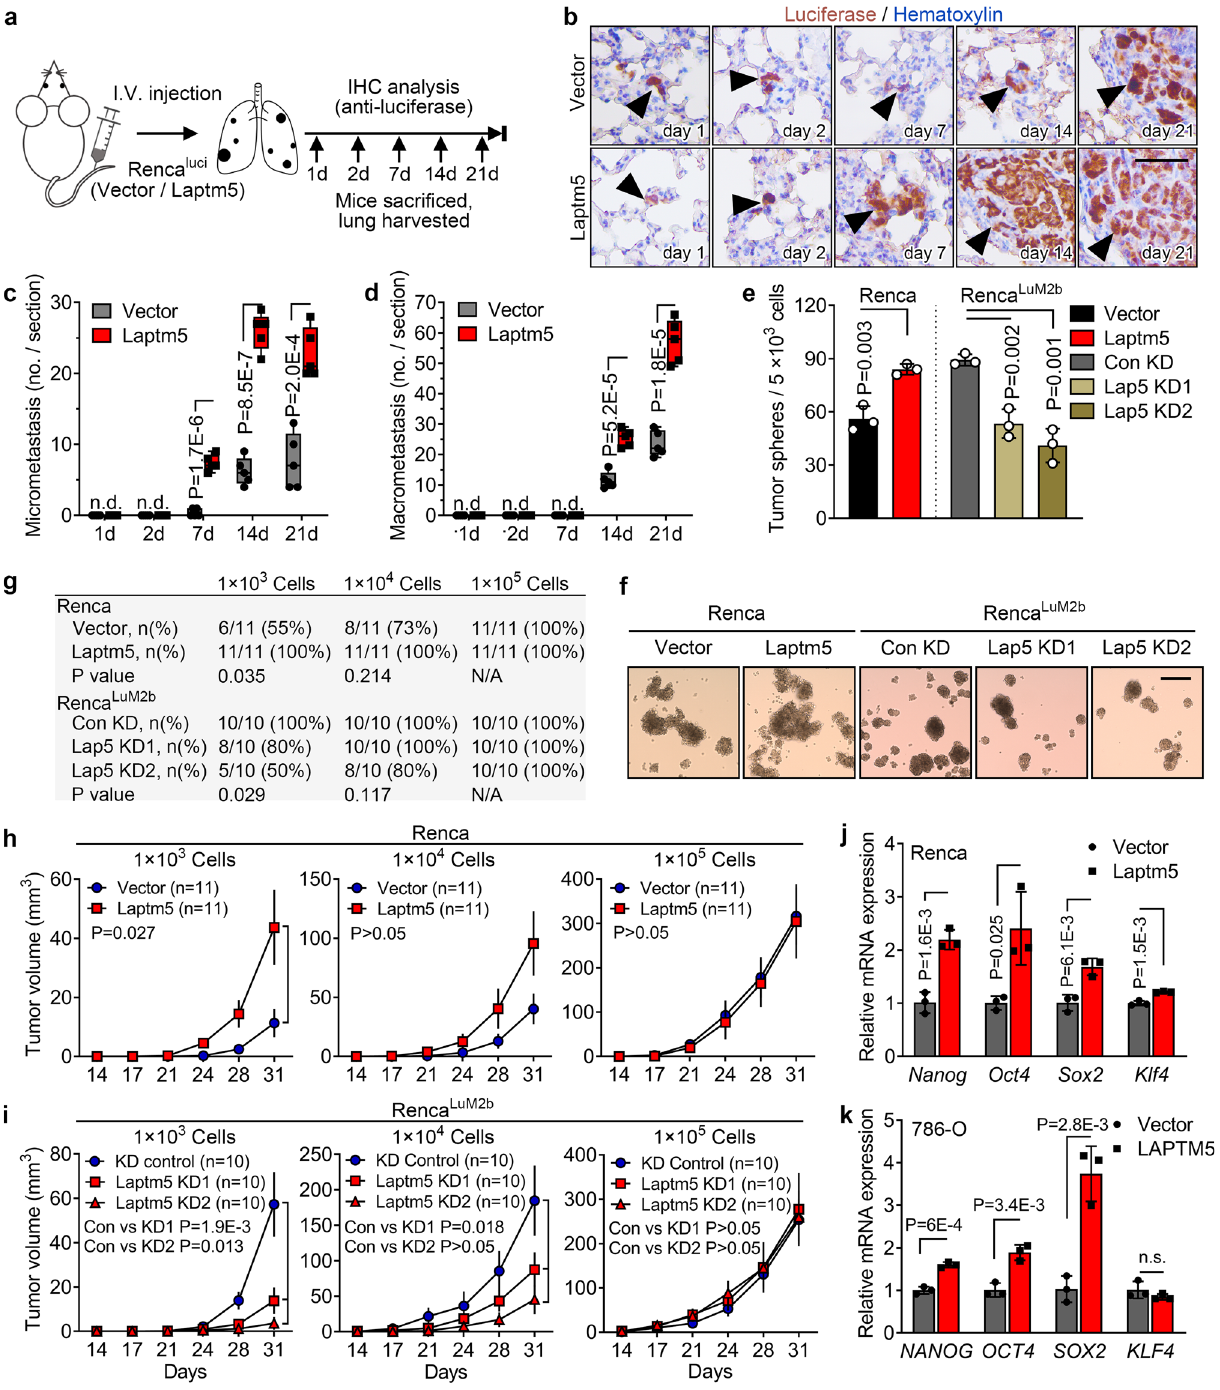
Fig. 3 LAPTM5 promotes self-renewal and cancer stem cell traits of RCC cells. a Schematic illustration for the steps of cell inoculation and lung metastases detection. I.V., intravenous. b Representative IHC images of luciferase staining in lung sections harvested from mice treated as in ( a ). Scale bar, 50 μ m. Quanti fi cation of micrometastasis (diameter < 100 μ m, c ) and macrometastasis (diameter ≥ 100 μ m, d ) per lung section in ( b ) ( n = 5 mice per group). Tumor sphere assay ( e ) and quanti fi cation of tumor sphere formation of indicated cells ( f , n = 3 per group). Scale bar, 200 μ m. g Frequencies of tumors formation in indicated groups. Tumor volumes of control and Laptm5-overexpressing Renca cells ( h , n = 11 mice per group) or control and Laptm5- silenced Renca LuM2b cells ( i , n = 10 mice per group) inoculated subcutaneously with indicated cell number. j , k qRT-PCR analysis of stemness markers in control and LAPTM5-overexpressing Renca ( j ) and 786-O cells ( k ). n = 3 per group. In c , d , the data are presented as whisker plots: midline, median; box, 25 – 75th percentile; whisker, minimum to maximum values, in ( e ), ( j ), and ( k ), the data are presents as mean ± SD, in ( h ) and ( i ), the data are presents as mean ± SEM. Two-tailed Student ’ s unpaired t -test was used for statistical analysis in ( c ) – ( e ), ( h ) – ( k ), χ 2 test for ( g ). Source data are provided as a Source data fi